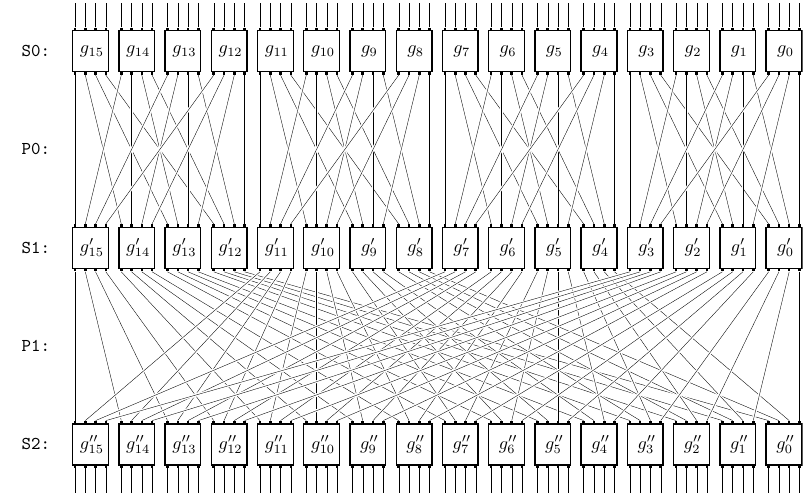
Figure 12: The Kam-Davida Three-Round 64-bit